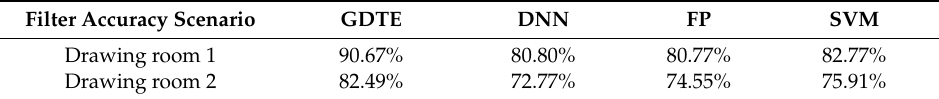
Table 2. The localization accuracy of different localization models without filtering.